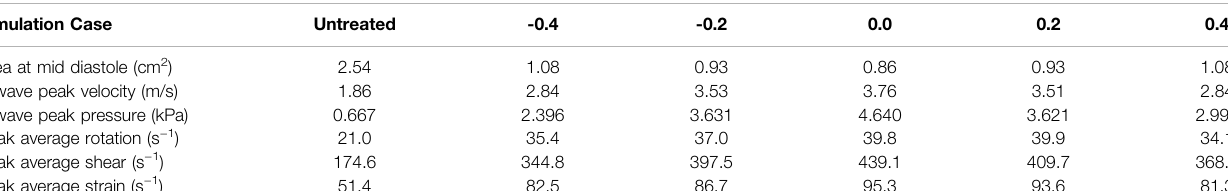
TABLE3| Peakvaluesintheuntreatedsimulationcase,andthecorrespondingvaluesforeachoftheMVCcases.Areaisgivenatmiddiastole.Velocityandpressurearethe maximum values reached anywhere in the LV at E-wave peak. Rotation, shear and strain are the maxima reached in Figure 5 .